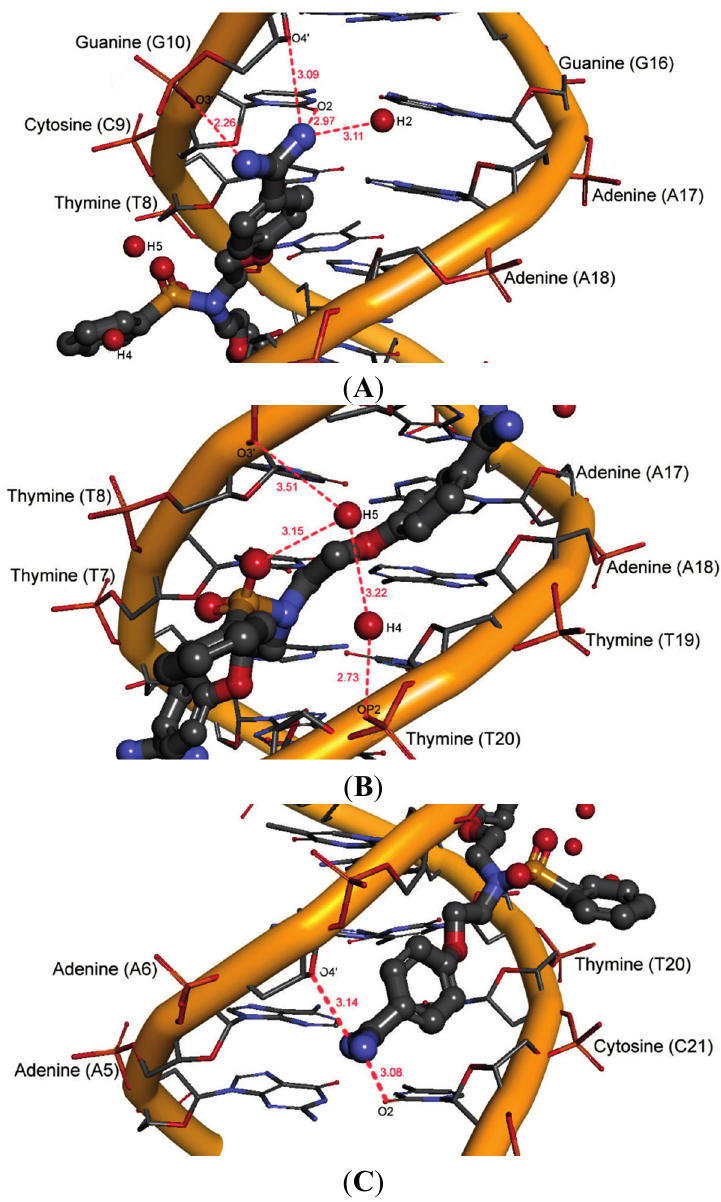
Figure 9. A view of three hydration sites for compound 11 in the minor groove (red lines—hydrogen bonds; length [Å]). ( A ) hydration site H2; ( B ) hydration sites H4–H5; ( C ) lack of hydration sites